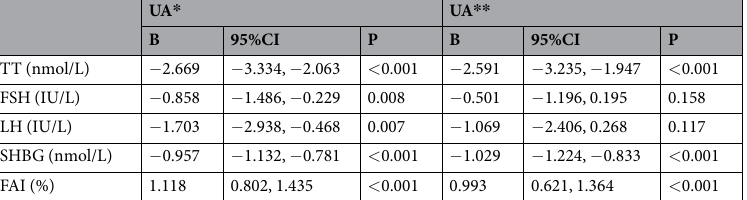
Table 4. Association of UA with sex-related hormones. Linear regression analysis was used. * was unadjusted; ** was adjusted by age. Abbreviations: UA, uric acid; TT, total testosterone; FSH, follicle-stimulating hormone; LH, luteinizing hormone; SHBG, sex hormone binding globin; FAI, free androgen index; B, regression coefficient; CI, confidence